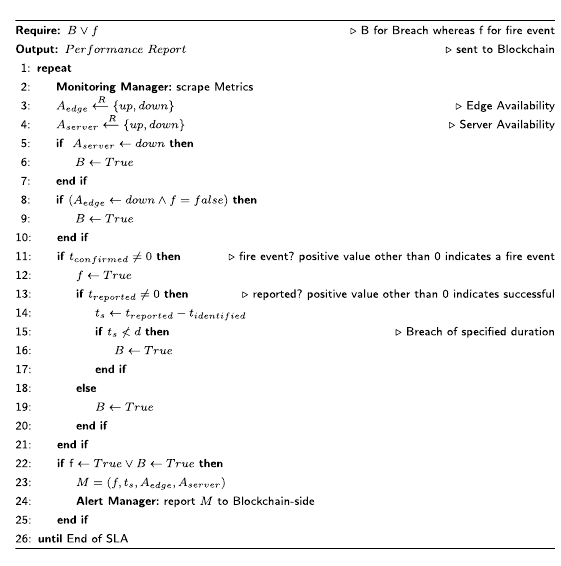
Algorithm 1 Reporting Mechanism to the Blockchain Side